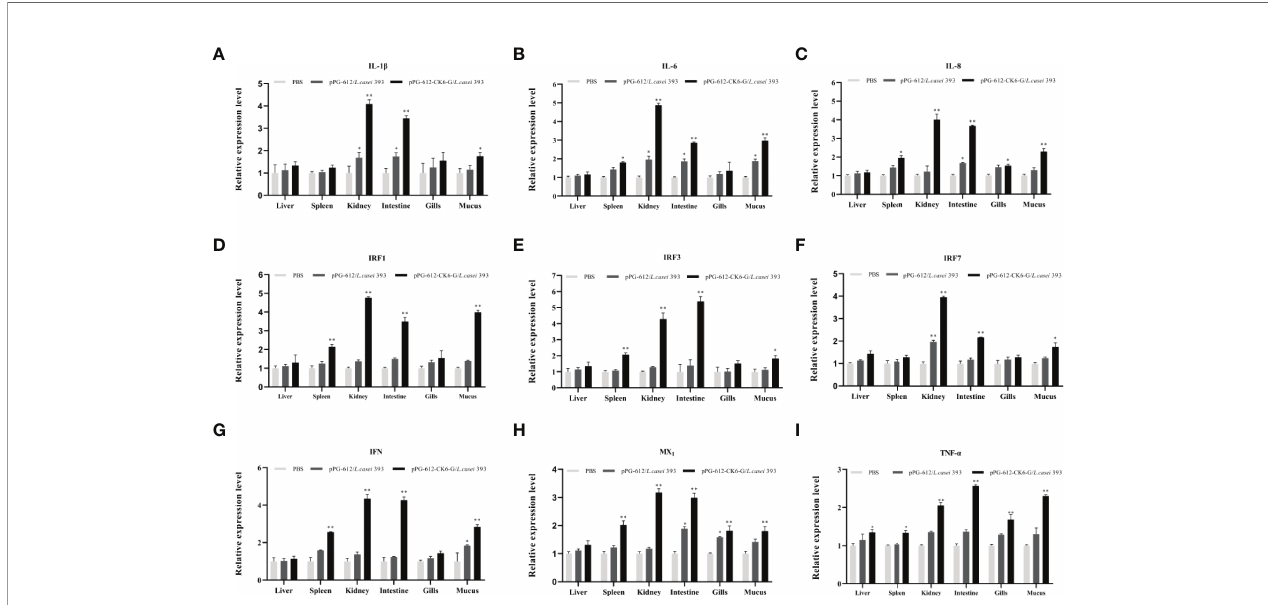
FIGURE 4 | The relative expression levels of cytokines in the liver, spleen, kidney, intestine, gill, and skin mucus on the 15th day after secondary immunization. (A) the relative expression of IL-1 b ; (B) the relative expression of IL-4 ; (C) the relative expression of IL-6 ; (D) the relative expression of IRF1 ; (E) the relative expression of IRF3 ; (F) the relative expression of IRF7 ; (G) the relative expression of IFN ; (H) the relative expression of MX1 ; (I) the relative expression of TNF- a . Data are presented as mean ± SD and P values were calculated using one-way ANOVA and LSD post hoc tests. * represents p <0.05, ** represents p <0.01.